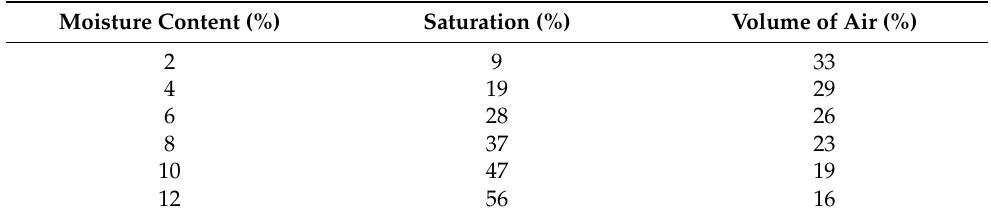
Table 3. Saturation and percentage of air volume for a given moisture